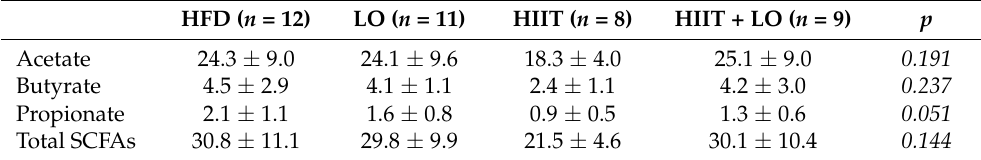
Table 3. Fecal acetate, butyrate and propionate concentration (µmol.g − 1 feces) in the four groups: HFD ( n = 12), LO ( n = 11), HIIT ( n = 8), and HIIT+LO ( n = 9) at the end of phase 2 (training and/or LO supplementation for 12 weeks). Total short-chain fatty acids (SCFAs) = acetate + butyrate + propionate.